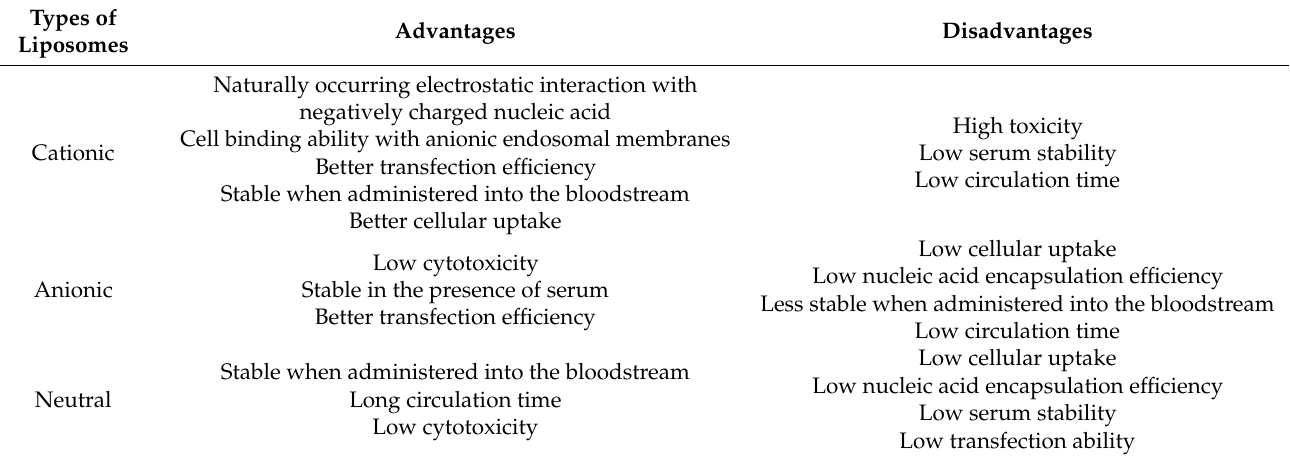
Table 9. Summary of the advantages and disadvantages of cationic, anionic and neutral liposomes used as a non-viral gene carrier, specifically for gene